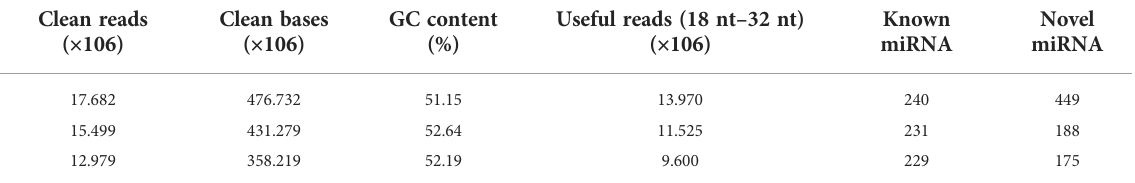
TABLE 1 Summary of miRNA sequencing datasets.